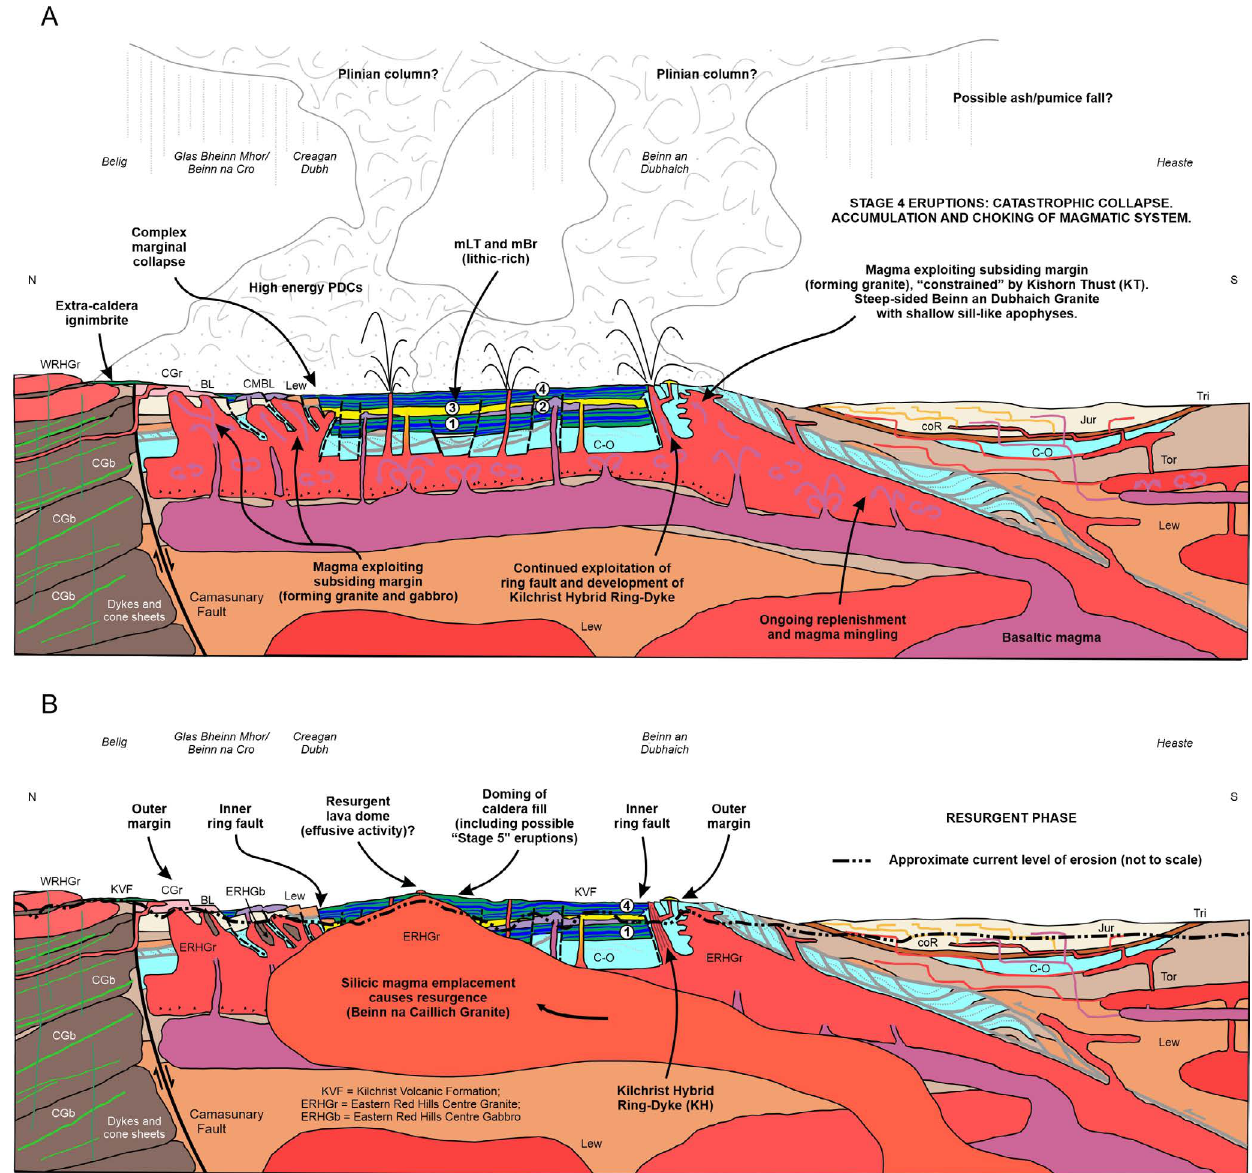
Figure 16: Stage 4 of KVF eruptions. [A] Caldera collapse and choking of magmatic system. The subsequent [B] resurgent phase resulted in emplacement of the Beinn na Caillich